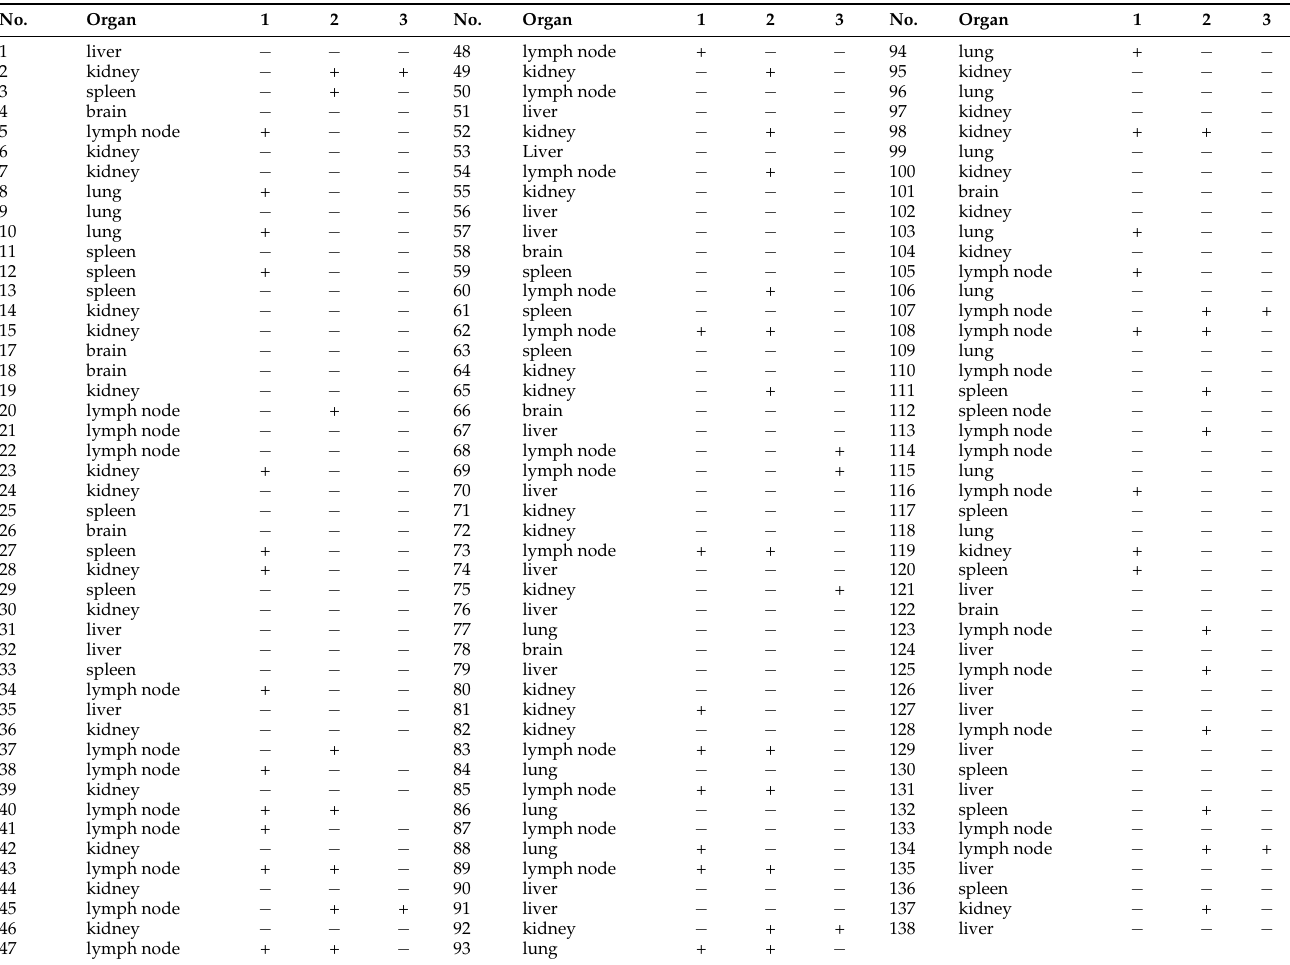
Table 5. Detection results of PCVs in different organs of wild